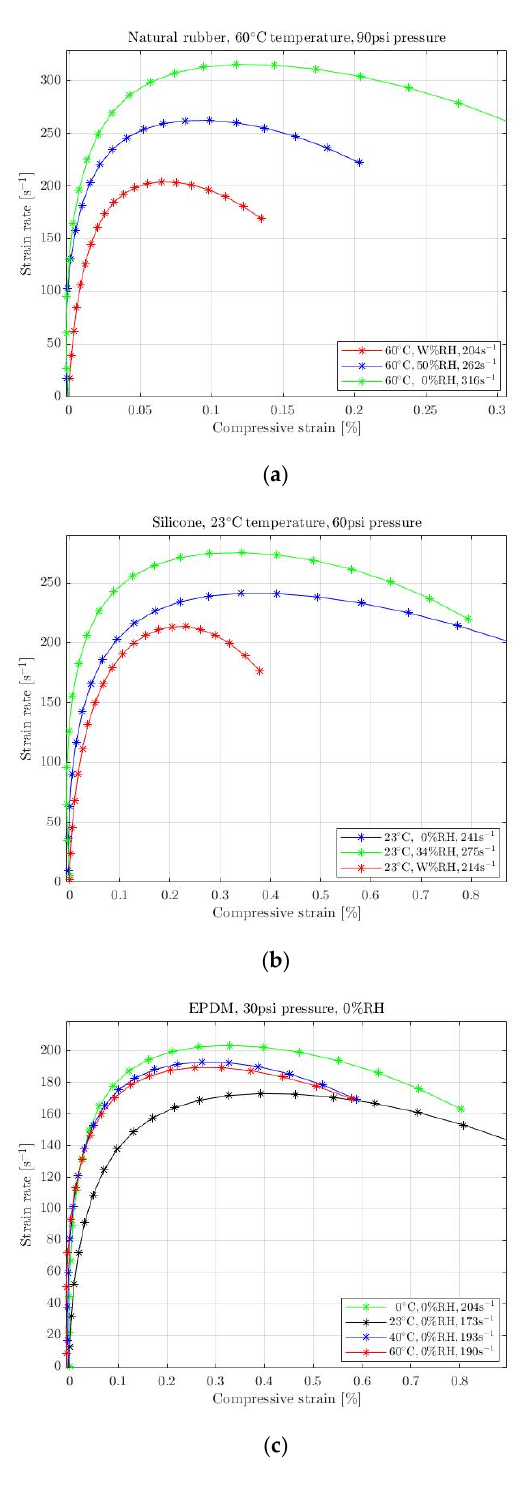
Figure 4. Applying the same pressure (either 90 psi or 60 psi or 30 psi) results in different strain rates of compressing ( a ) natural rubber, ( b ) silicone, and ( c ) EPDM specimens under different envi- ronmental conditions.